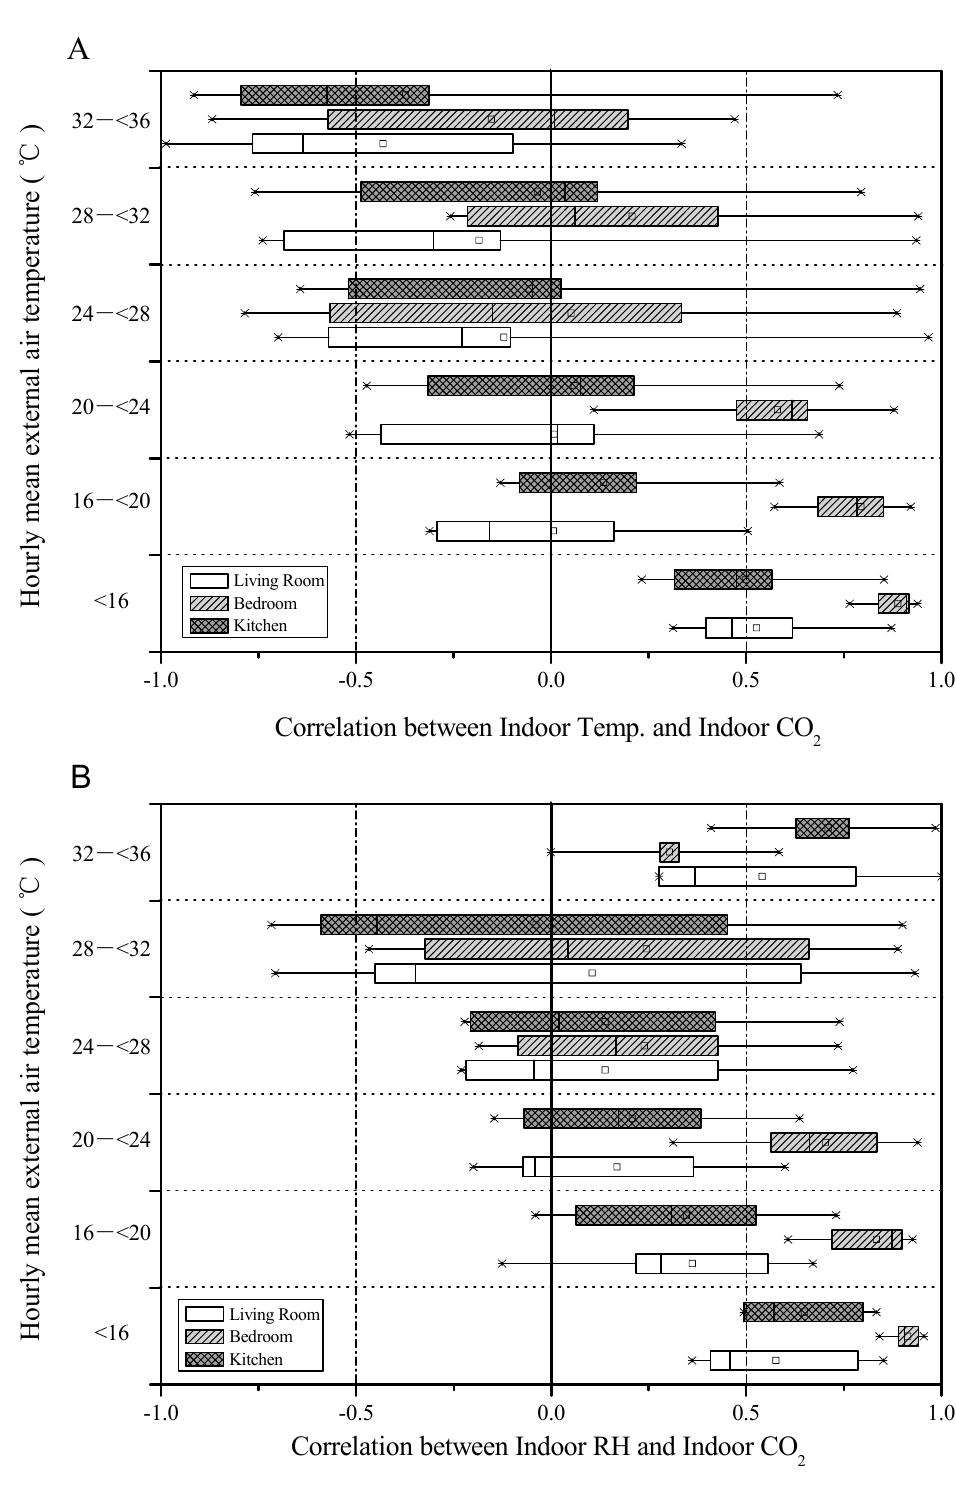
Figure 6. Boxplots of variables correlation in all seasons for the eight apartments ( A ) indoor temperature and carbon dioxide, ( B ) indoor relative humidity and carbon dioxide, from March 2016 to March 2017 (Boxplots indicate the minimum, first quartile, median, third quartile, and max).